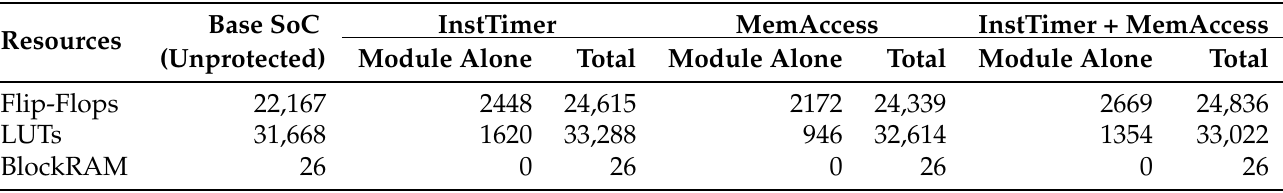
Table 3. Area footprint of MATANA for Prime +